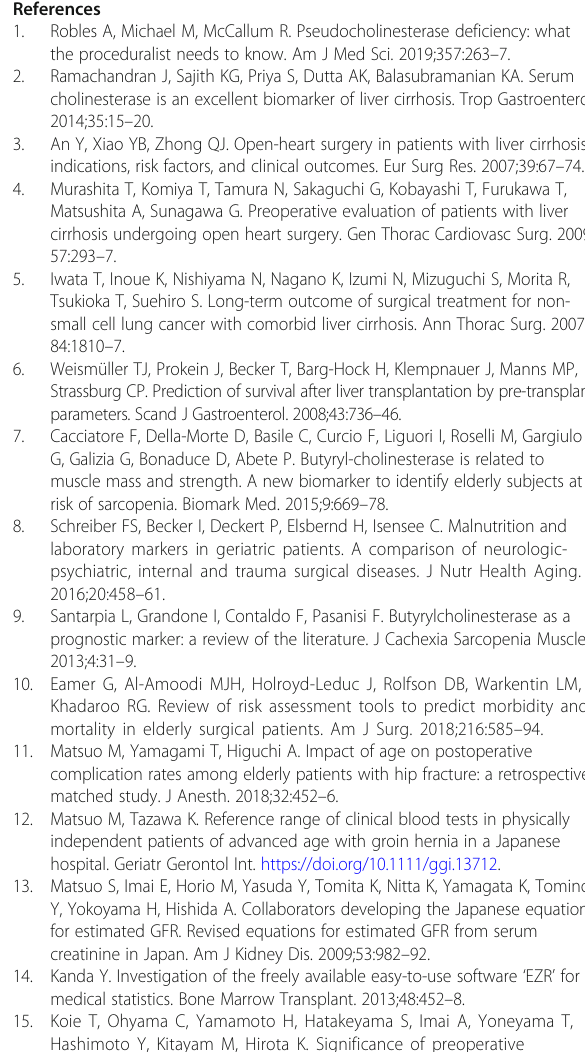
Logistic regression analysis was used to adjust age, body mass index, American Society of Anesthesiologists class ≥ 3, history of heart failure or ischemic heart disease, operative indication, and perioperative blood transfusion. ChE cholinesterase, OR odds